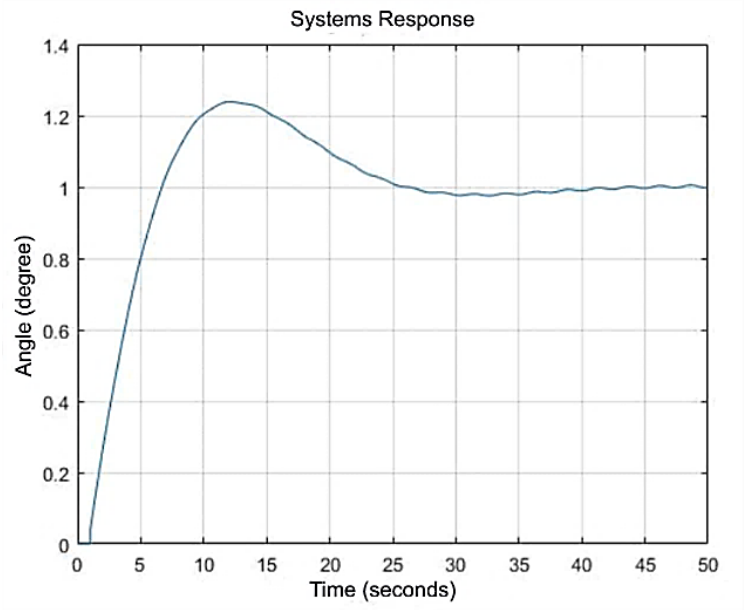
Figure 14. System simulation result with PID